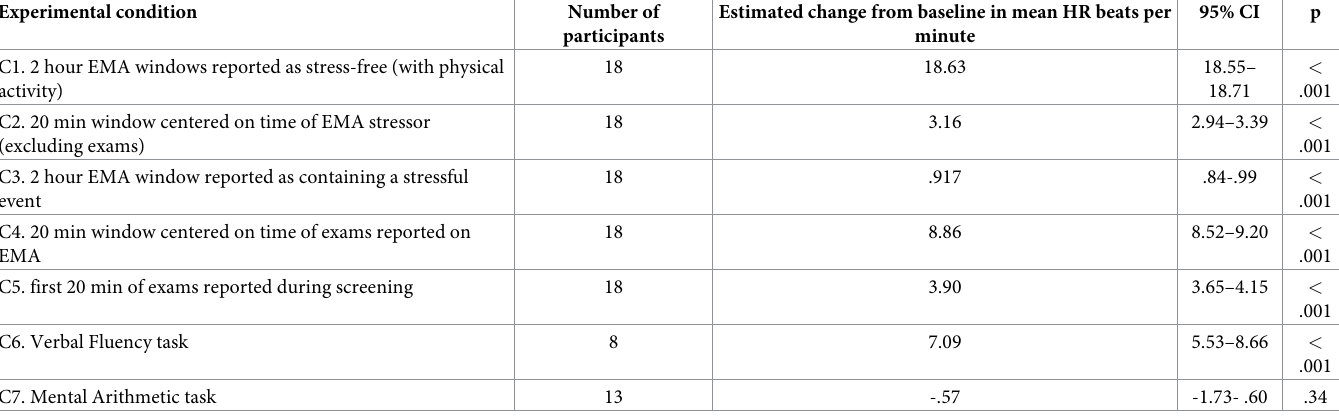
Table 1. Estimates in heart rate change during various comparisons. The change in HR is relative to the baseline HR as estimated by mixed effects modeling (baseline HR = 76.7, 95% CI = 72.8–80.6) calculated from 2-hour EMA windows reported as stress-free with no physical activity. Experimental condition Number of